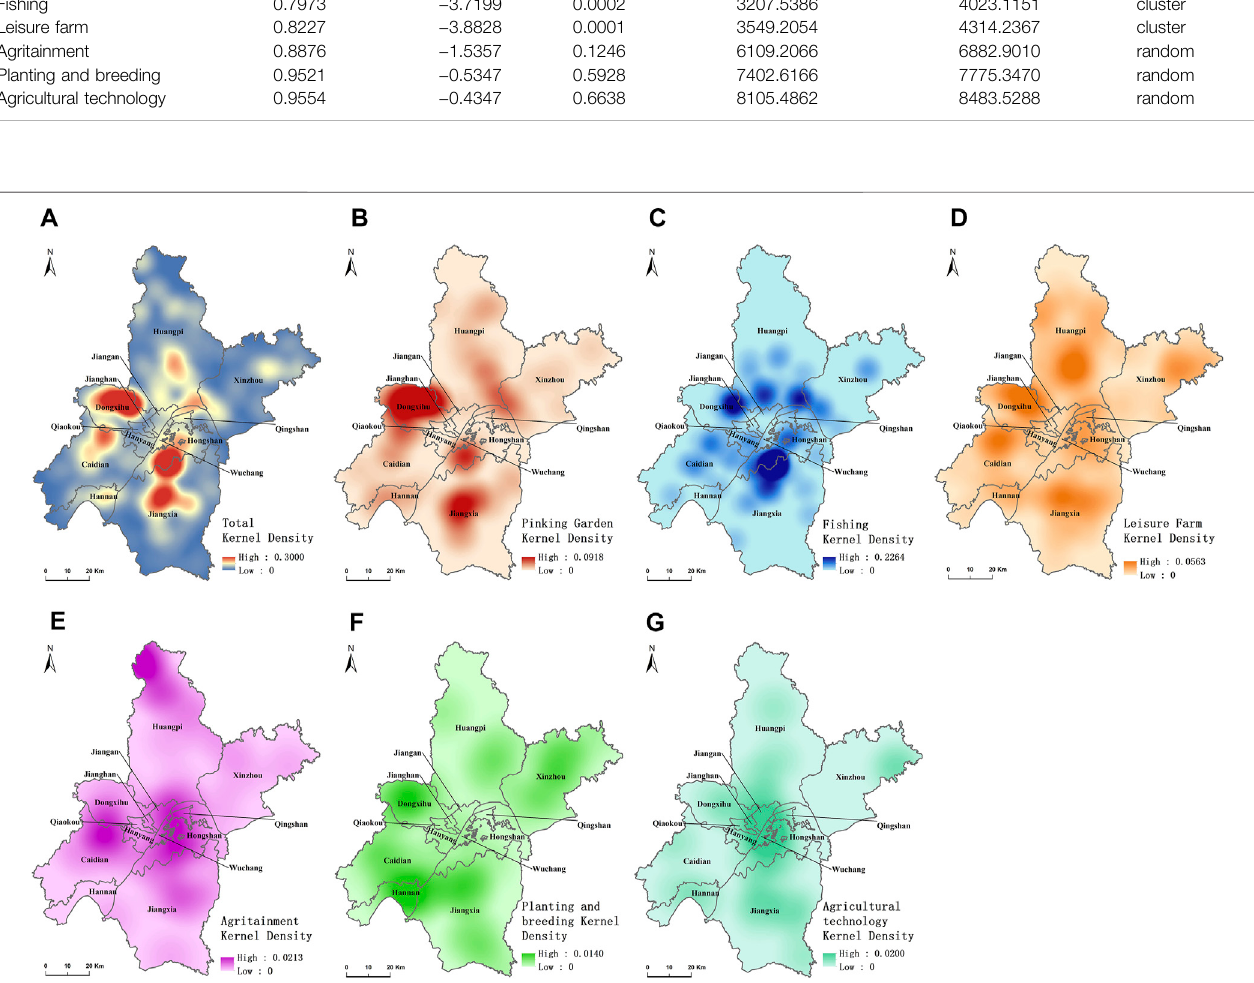
Frontiers in Environmental Science |